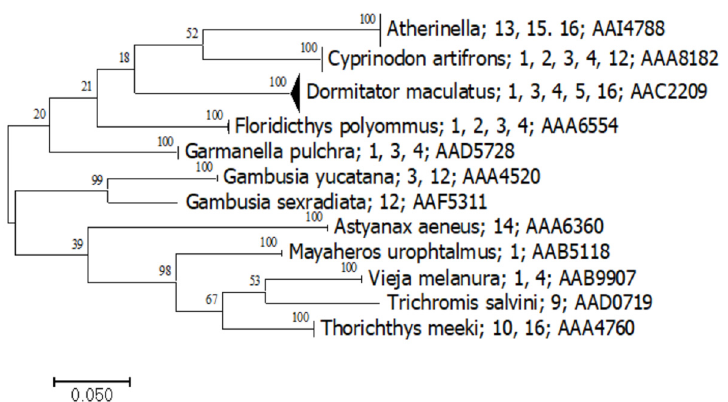
Figure 6. Simplified tree for Actinopterygii. Numbers represent the aquatic system, as presented in Table 1. The last number corresponds to the BIN assigned in BOLD. Bootstrap support is shown in each branch. Table 2. Primers used in the eDNA process. All listed primers are 5 ′ to 3 ′ . The explanation is in the text. Primer Name